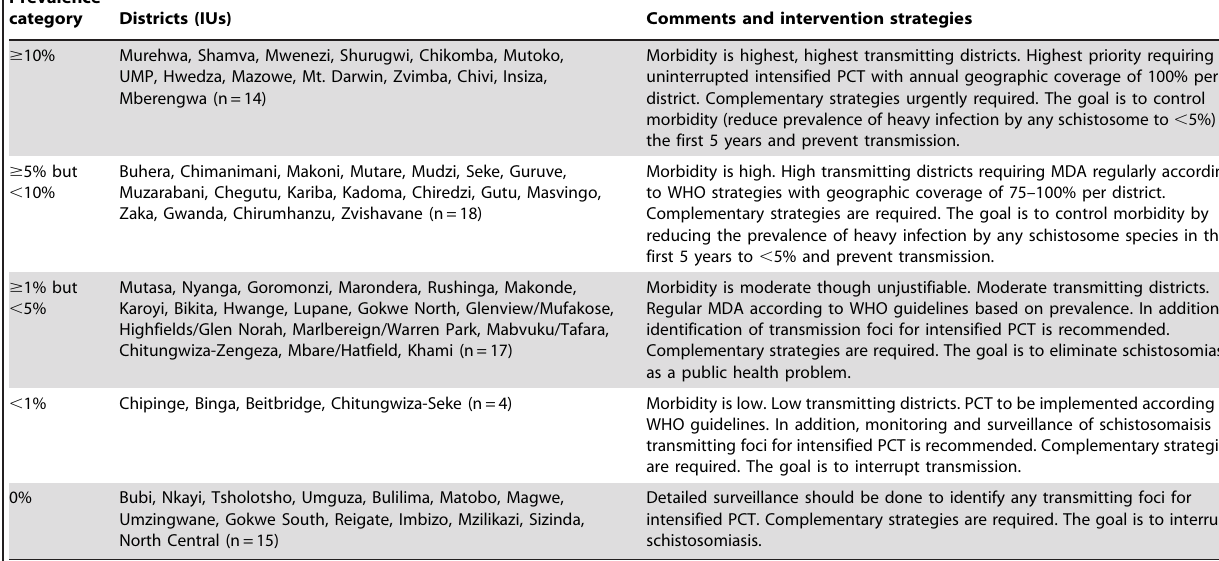
Table 4. Stratification of 68 districts in Zimbabwe according to prevalence of heavy infection with any schistosome species (morbidity) and the proposed intervention strategies in